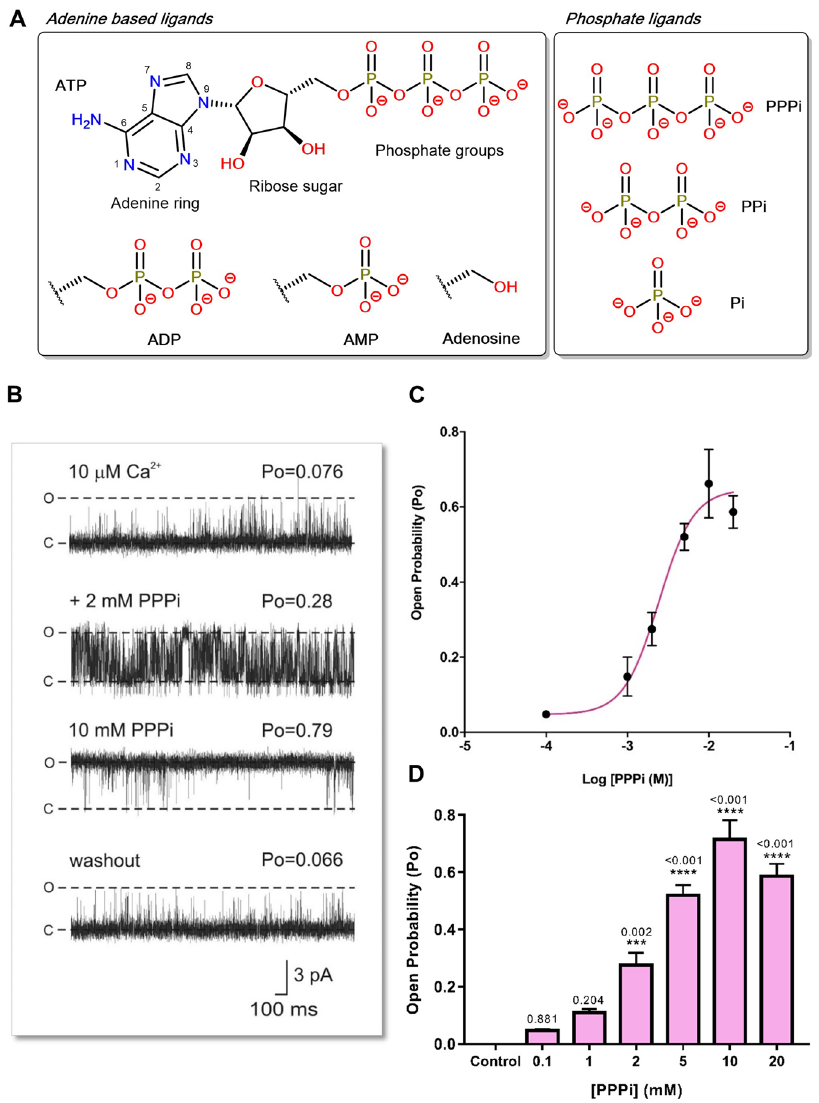
Figure 2. Reversible effects of PPPi on RyR2 channel gating. ( A ) A molecule of adenosine triphosphate (ATP) is shown with the adenine core, ribose ring and phosphate groups. The adenine-based ligands and phosphate ligands investigated in this study are illustrated, and their comparison to ATP are indicated. ( B ) Representative current fluctuations through a single RyR2 channel incorporated into a bilayer are shown. In the top trace, the channel is activated by 10 μ M cytosolic Ca 2 + alone. 2 mM and 10 mM PPPi are then added sequentially to the cytosolic chamber as indicated. After perfusing away the PPPi (washout), Po returns to control levels. The holding potential was 0 mV. O and C represent the open and closed channel levels, respectively. The Po above each trace refers to the value determined over 3 min. ( C ) The relationship between PPPi concentration and RyR2 Po for channels where the effect of PPPi was completely reversible. Increasing concentrations of PPPi were added sequentially. The EC 50 value was 2.4 mM and the Hill coefficient was 2.03. ( D ) The bar chart illustrates that the increases in Po in the presence of PPPi were highly significant at high concentrations. Mean values ± SEM are shown, and p values relative to control are indicated above each bar (n = 6; *** p < 0.001; ** p < 0.01; * p <